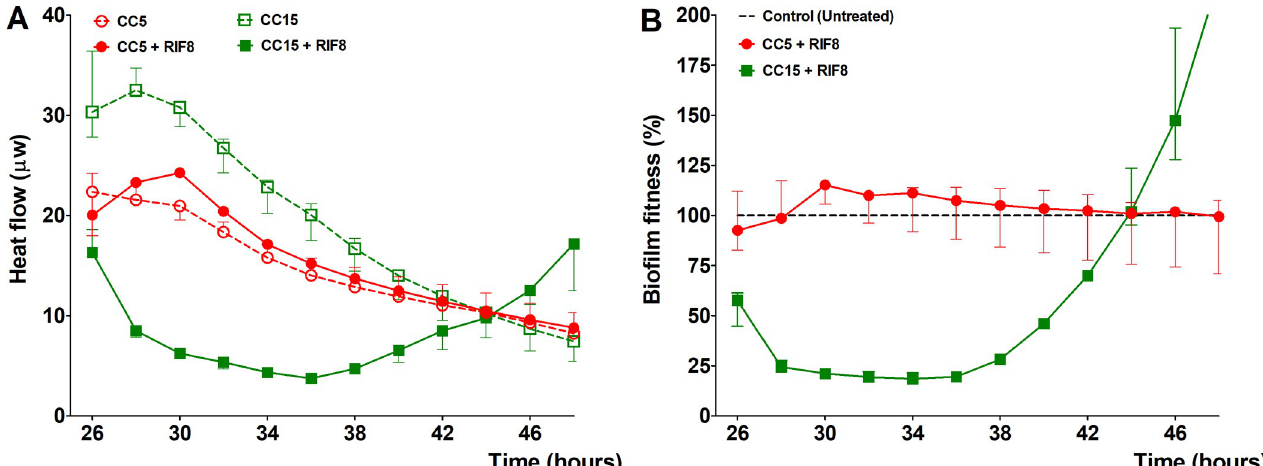
Fig 1. Normalization of data generated by isothermal microcalorimeter. Heat-flow of Mu50 (CC5) and CC15 during co-incubation with and without 8 μ g/ mL rifampicin (A). Biofilm fitness of Mu50 (CC5) and CC15 during co-incubation with and without 8 μ g/mL rifampicin is given as percentage of the heat-flow of the rifampicin-treated biofilms relative to untreated biofilms (B). Dashed black lines indicate untreated (control) (B). Error bars represent median with range (n = 3).